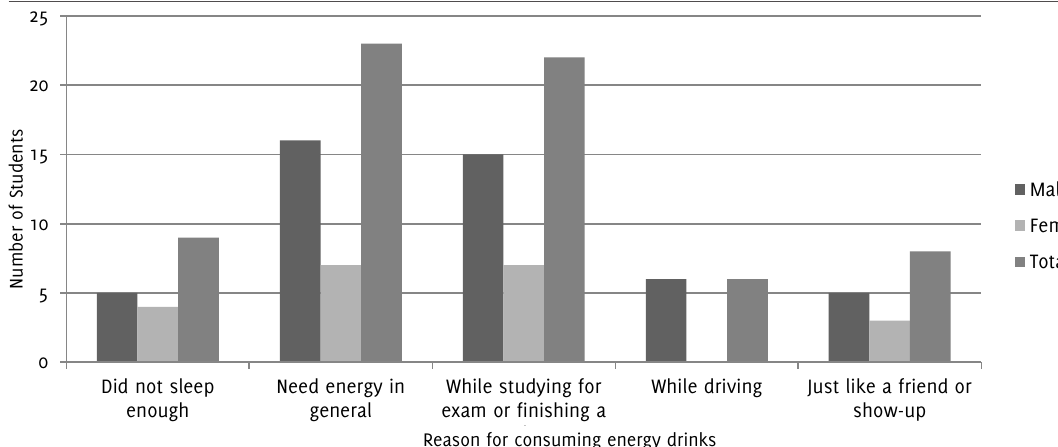
Figure 2. Reasons for Energy Drink Consumption among Medical Students in Clinical Years.